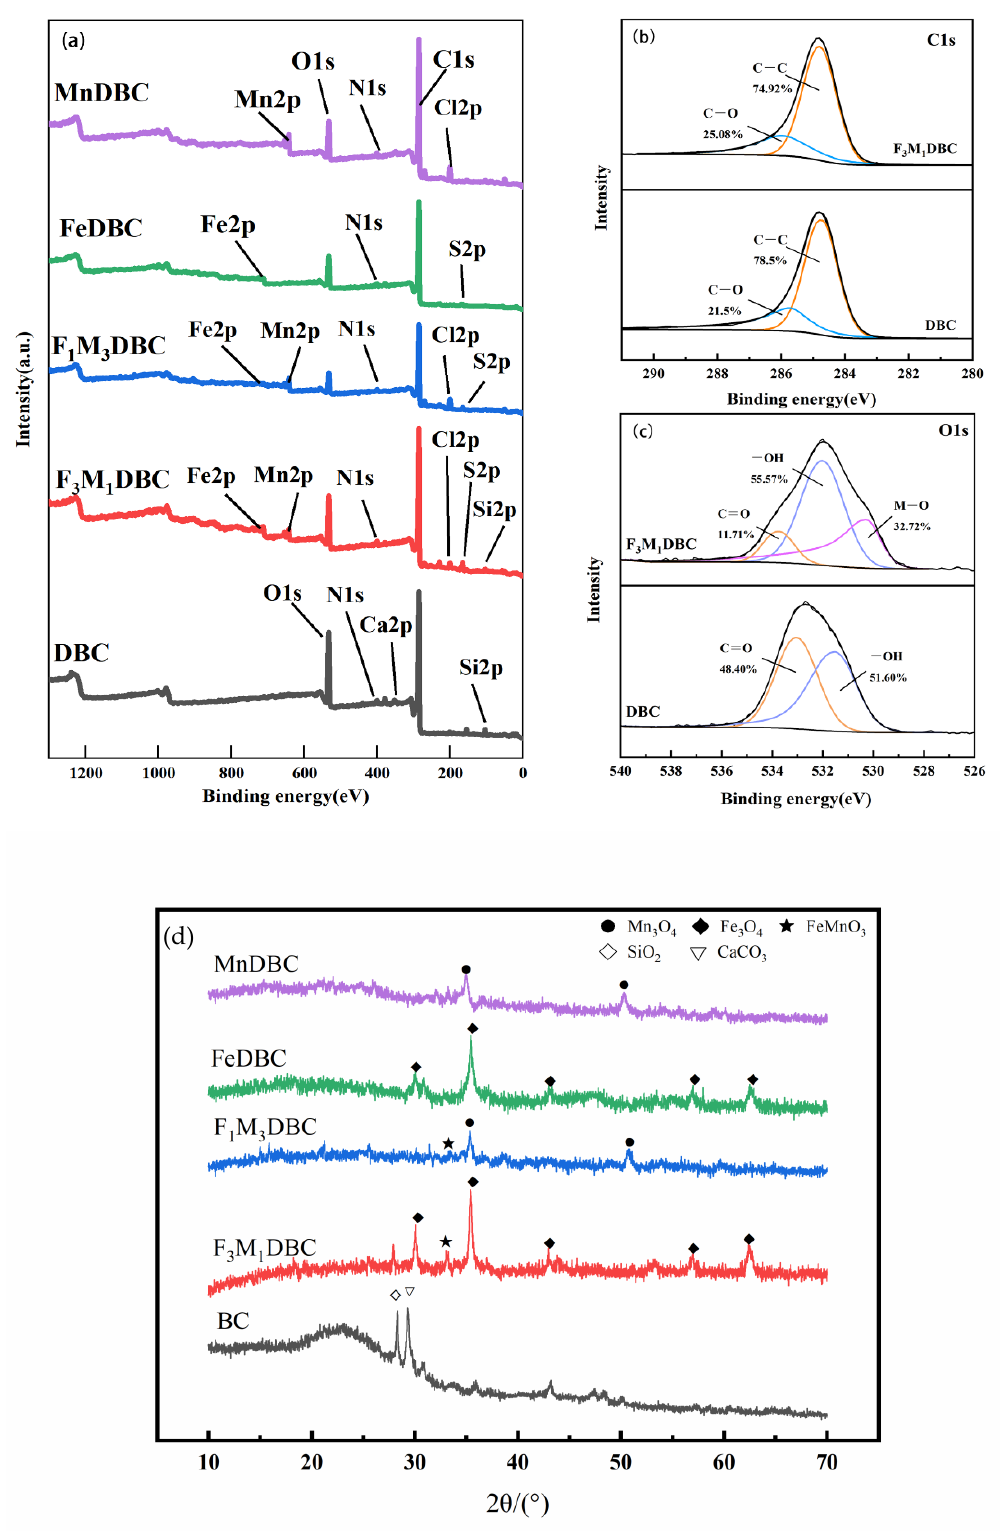
Figure 2. The XPS spectra of original biochar and Fe-Mn modified biochar ( a ), the C1s XPS spectrum of DBC and F 3 M 1 DBC ( b ), the O1s XPS spectrum of DBC and F 3 M 1 DBC ( c ), and XRD of original biochar and modified biochar ( d ).